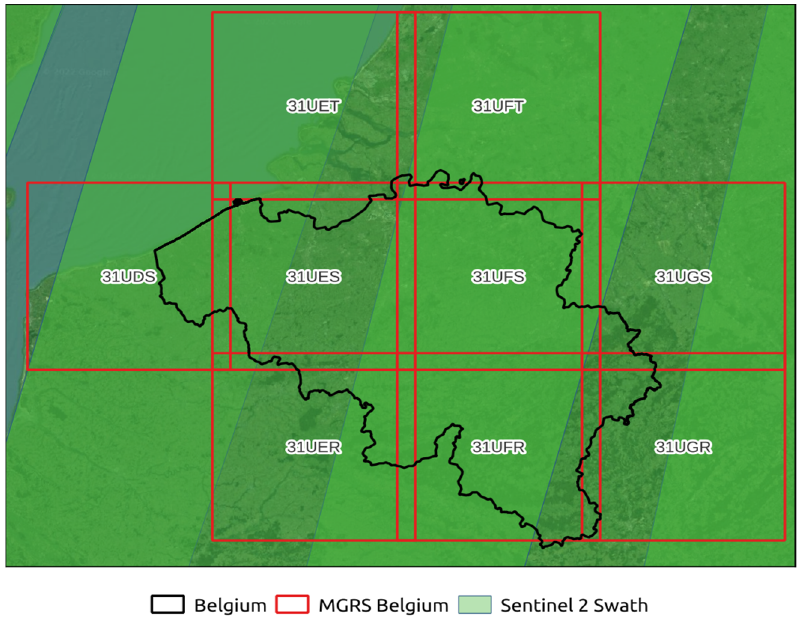
Figure 10. BRDF evaluation area over Belgium. Red lines show the MGRS tiles, and green polygons show the S2 swath coverage. Darker green areas show overlaps between neighboring swaths. Table 4. Summary of difference of S2L bands over Belgium MGRS tiles, considering a window of 1 to 5 days. Columns shown are the mean, standard deviation and correction percentage of NBAR algorithms. Positive and negative values represent increase and decrease of errors,